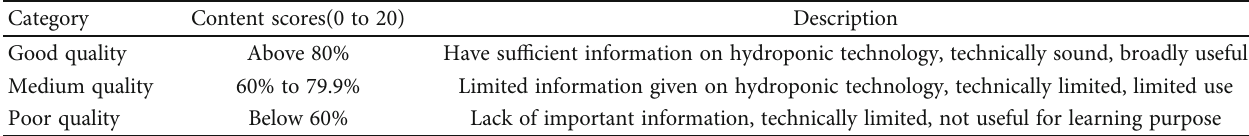
Table 4: Grading of YouTube contents regarding hydroponic technology.